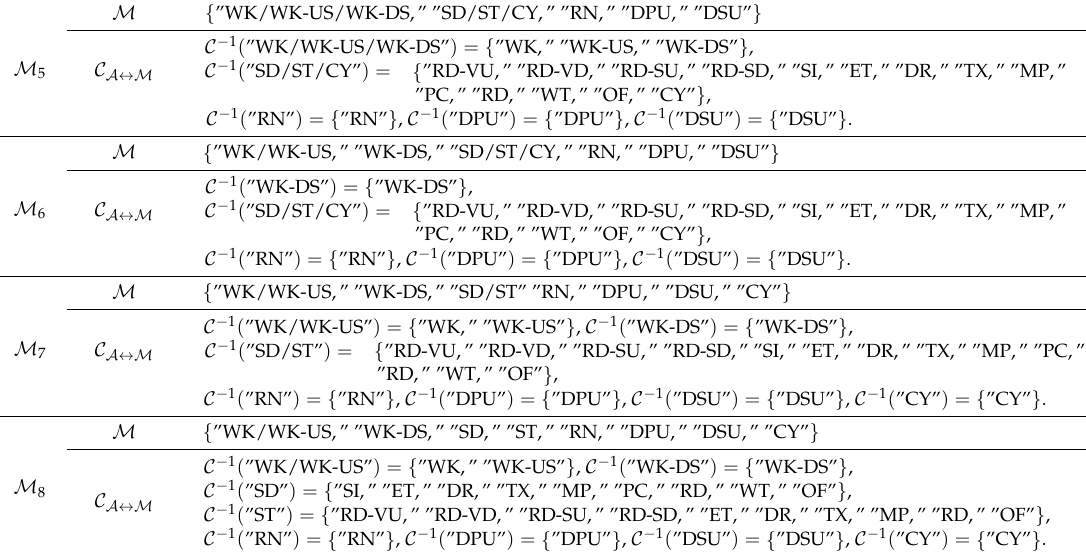
Table 4. All grouping methods established during the adjustment of the grouping method when the proposed algorithm is applied to the Multimodal